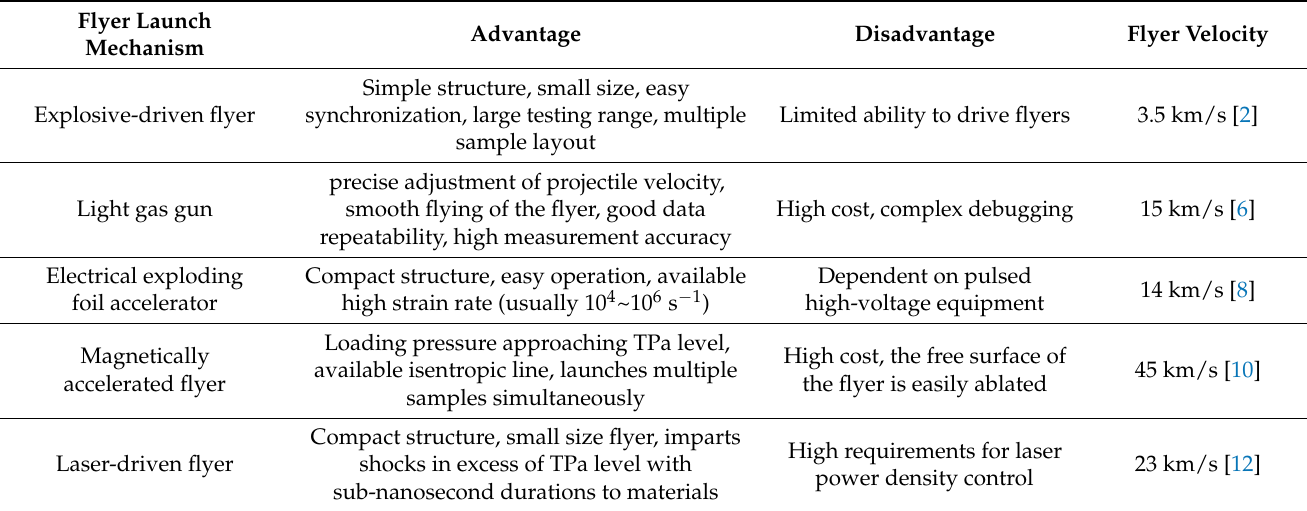
Table 1. Comparison of different flyer-driving